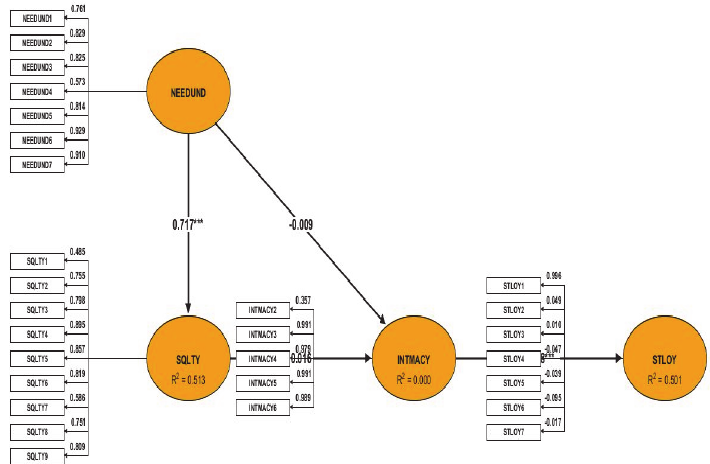
Fig. 1. Conceptual